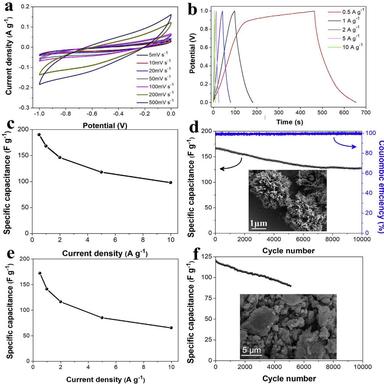
CV curves (a), GCD curves (b) and specific capacitances (c) of PF-NiFe2O4 at different current densities. Cycling stability and coulombic efficiency of PF-NiFe2O4 at 1 A g-1 (d), and SEM image of the PF-NiFe2O4 after cycling (inset in d). Specific capacitances of the bulk NiFe2O4 at different current densities (e), cycling stability of the bulk NiFe2O4 at 1 A g-1 (f), and SEM image of the bulk NiFe2O4 after cycling (inset in f).